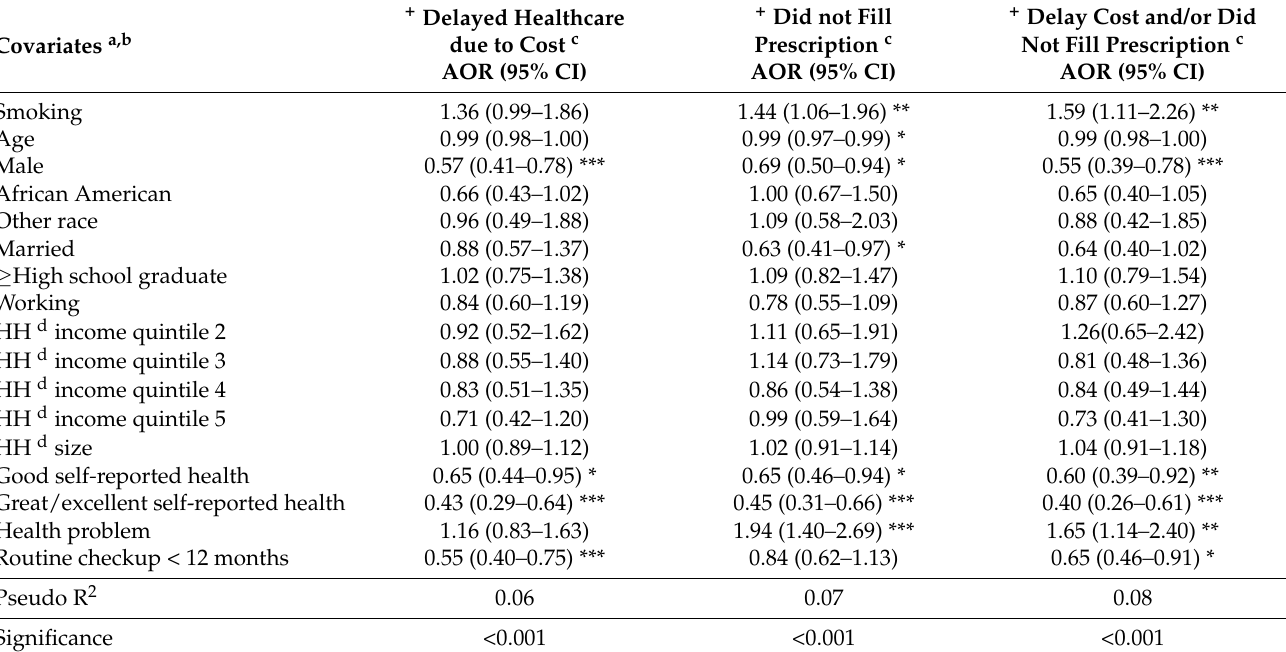
Table 2. Association between smoking and key outcomes variables +